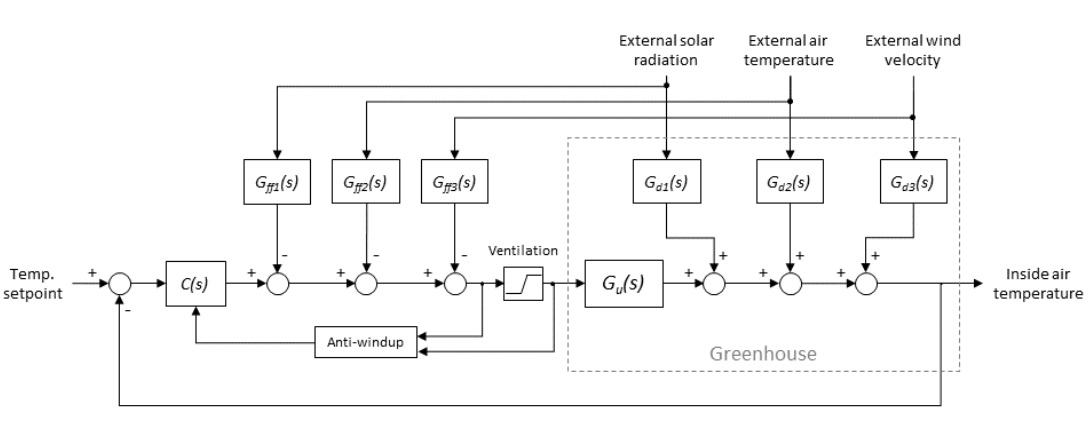
Figure 11. Control scheme for the inside air temperature of a